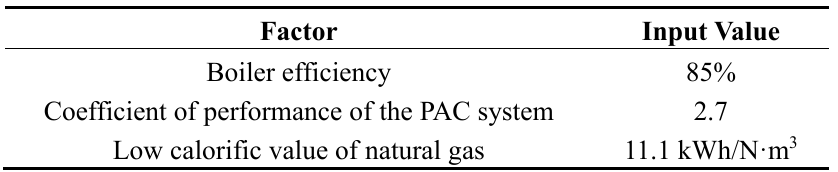
Table 8. Values for end-use energy